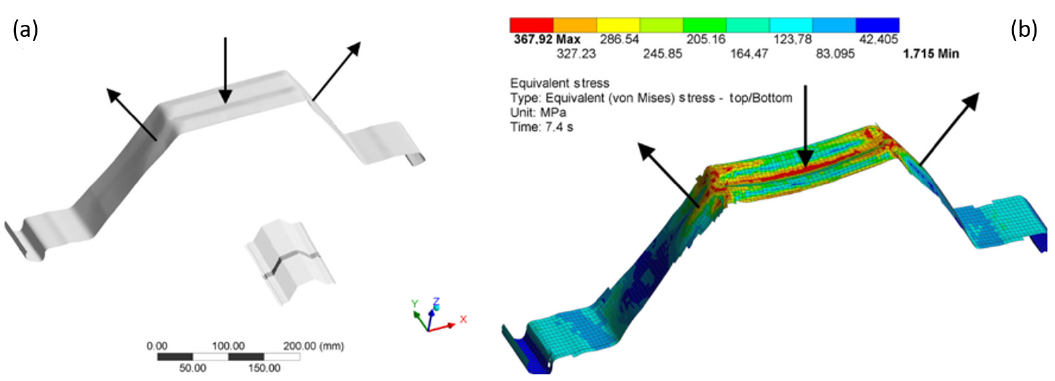
Figure 17. Profile surface’s geometry: ( a ) directions of surface bends, ( b ) von Mises stresses (phase